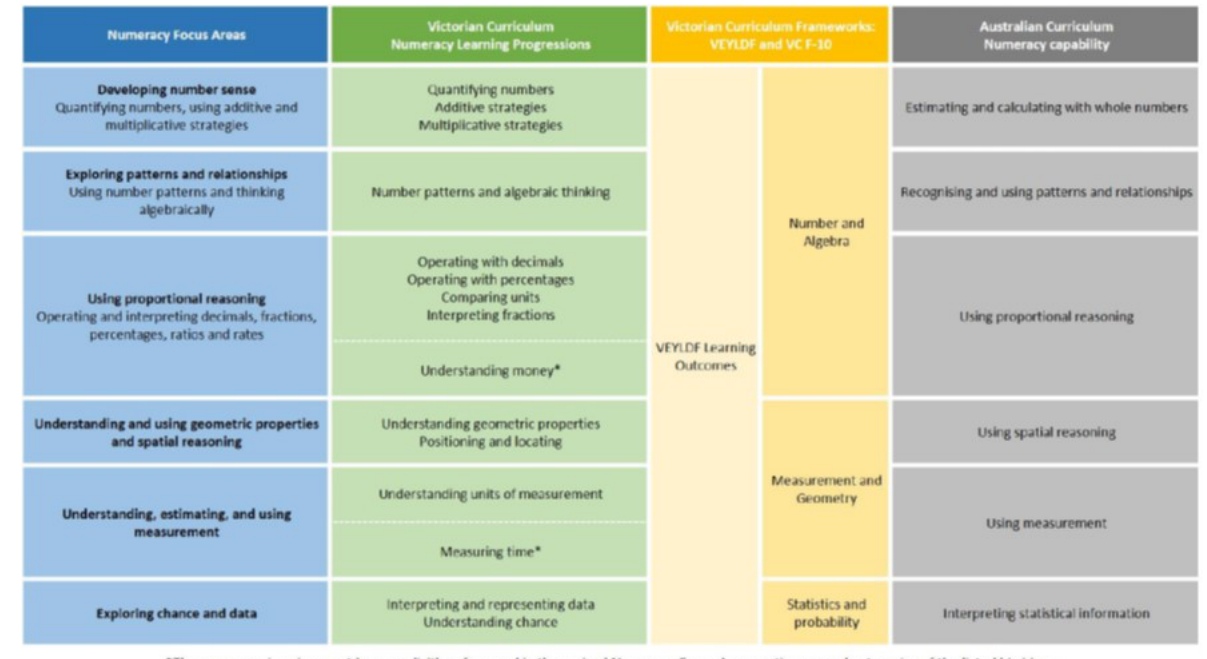
Numeracy Focus Areas and Their Alignment to Key State and National